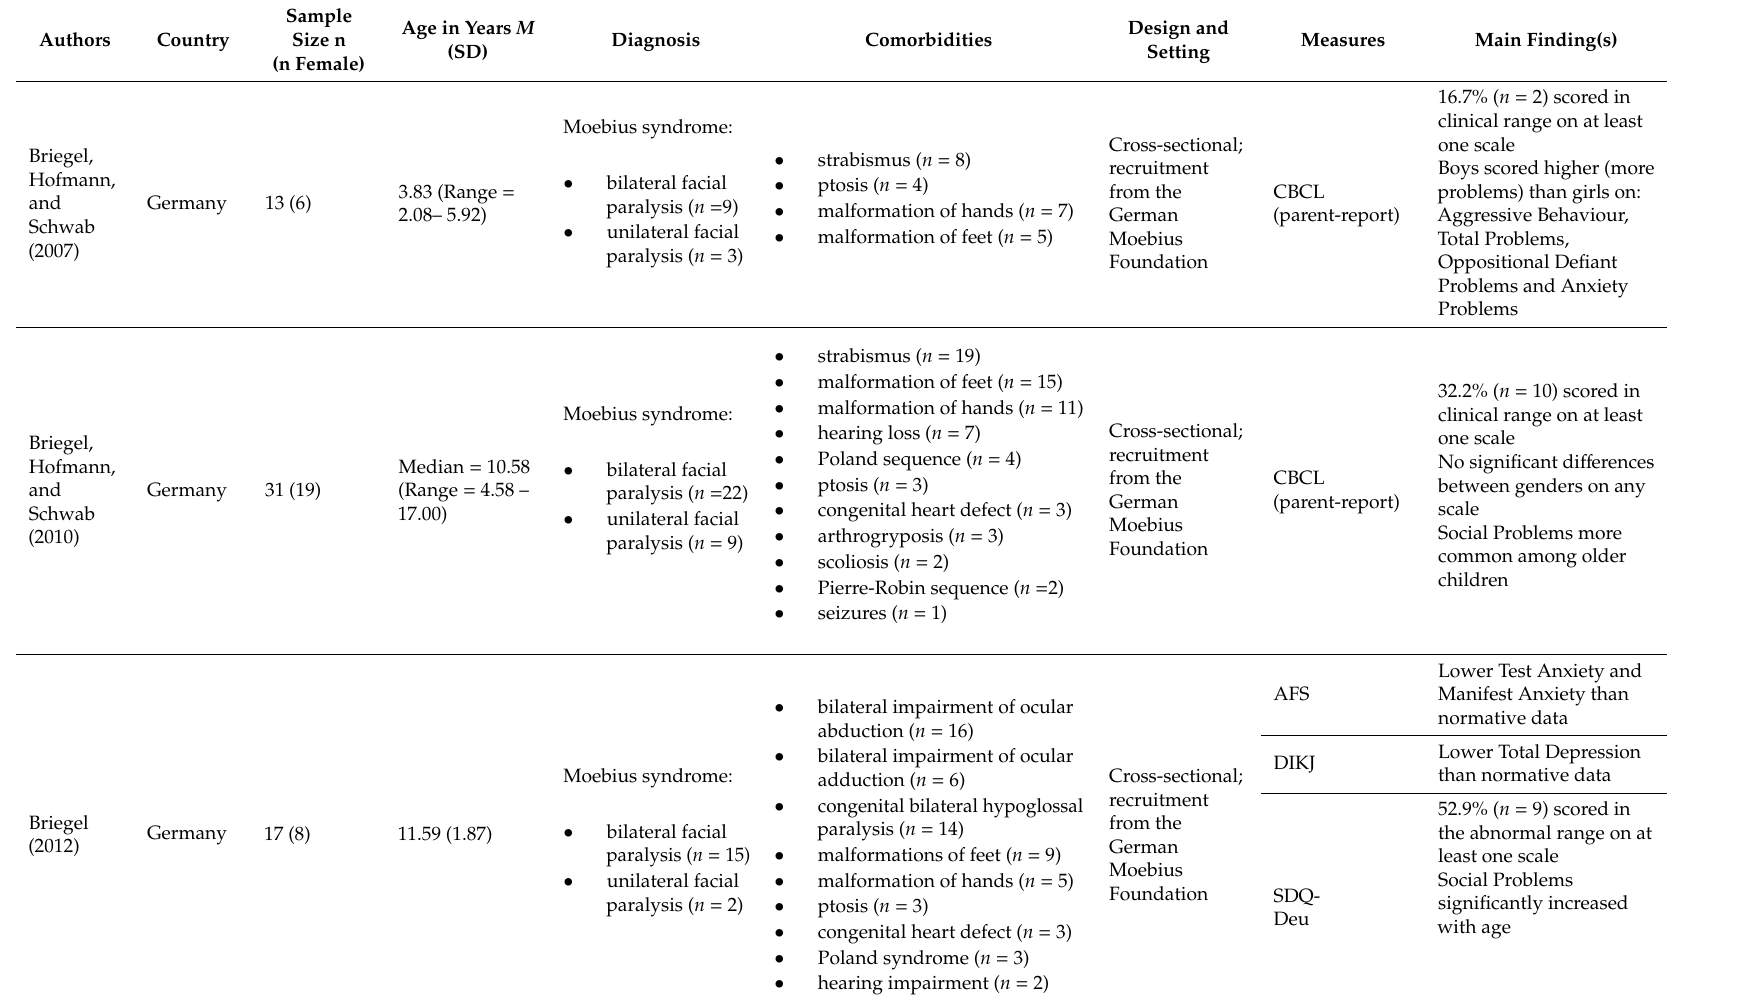
Table 3. Characteristics of included